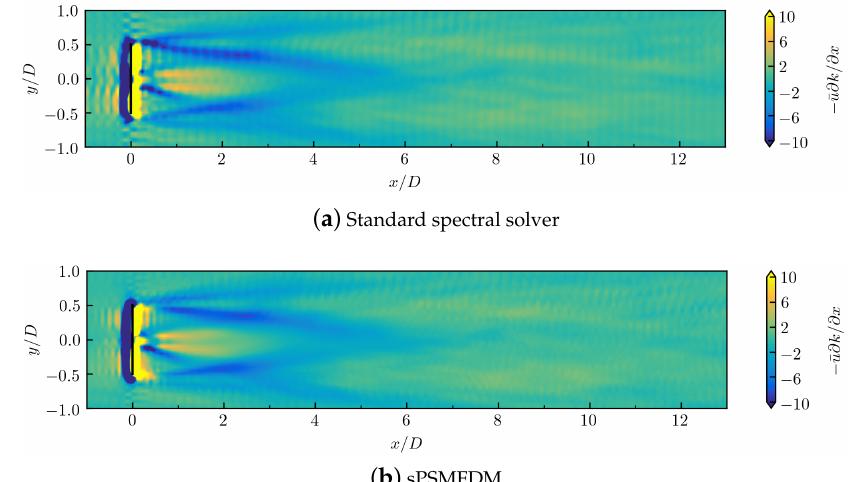
Figure 6. Comparison of the contours for ¯ u ∂ k / ∂ x , the streamwise advection of turbulent kinetic energy − (TKE), calculated by ( a ) the standard pseudo-spectral method and ( b ) the proposed sPSMFDM,